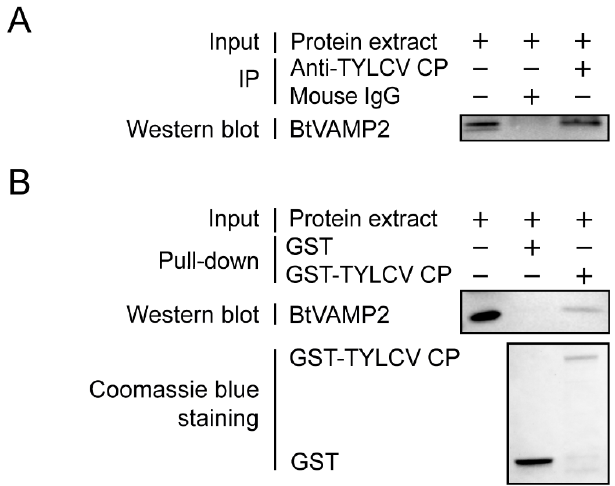
Figure 2. Interaction analysis between BtVAMP2 of MEAM1 whitefly and TYLCV CP. ( A ) Co-IP assay. Cytoplasmic proteins of MEAM1 were extracted following a 7 d virus acquisition and then the proteins were incubated with either anti-TYLCV CP mouse mAb and protein G-Sepharose beads or mouse IgG and protein G-Sepharose beads as a negative control. After Co-IP, anti-BtVAMP2 rabbit pAb was used to detect BtVAMP2 by Western blot. ( B ) GST pull-down analysis. GST-TYLCV CP or GST proteins were expressed and combined with the glutathione Sepharose beads, before being added to the native cytoplasmic protein of MEAM1. Finally, anti-BtVAMP2 rabbit pAb was used to detect whether the BtVAMP2 was pulled